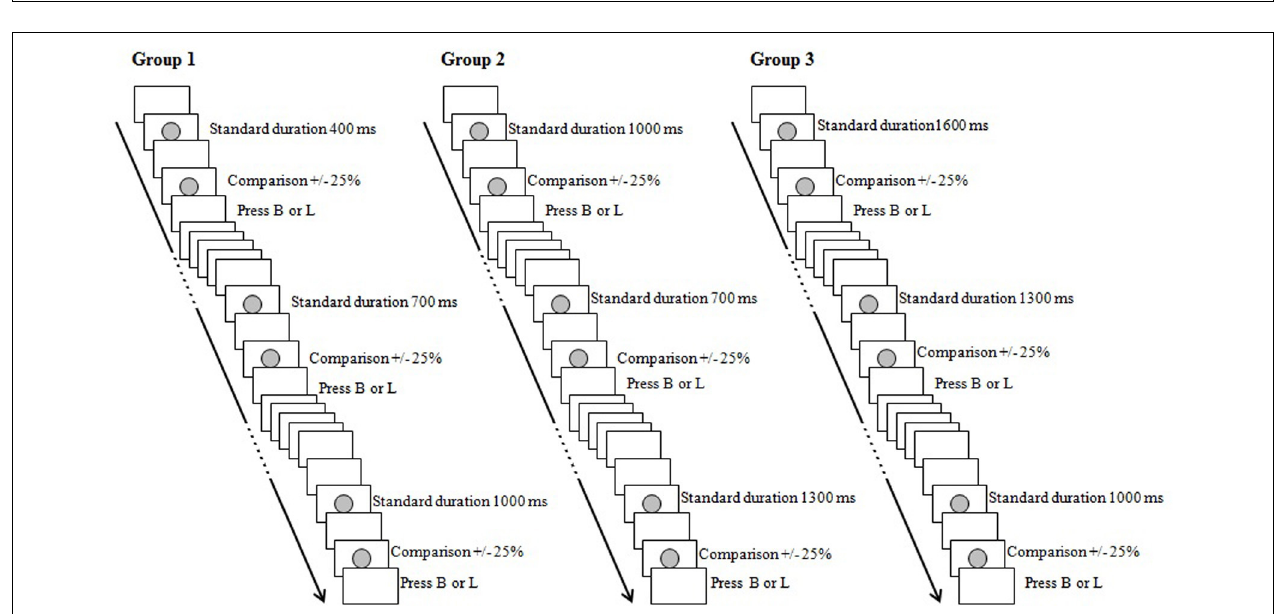
= 0 . 276] indicating that p